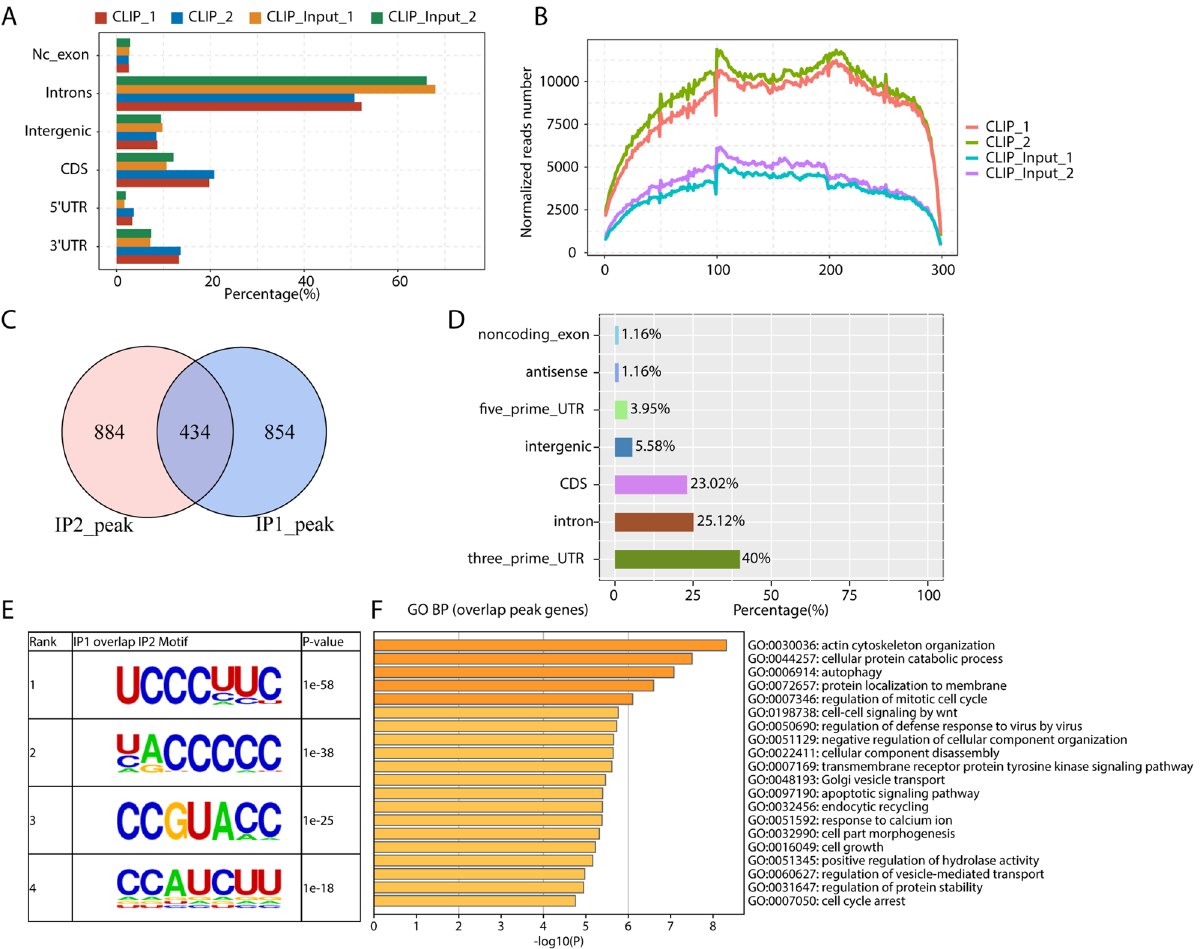
Figure 4. CLIP-seq analysis revealed the RNA binding features of PCBP1 in T lymphoma cell line. ( A ) Bar plot showed the reads distribution across reference genome. ( B) Peak reads density in 5 ′ UTR, CDS and 3 ′ UTR. These three regions of each gene were separated into 100 bins, the UPF1 peak reads in each bin was calculated. The reads density of UPF1 peaks in all genes were plotted. ( C ) Venn diagram showed the overlap peaks in two IP samples. ( D ) Bar plot showed the overlap peaks reads distribution across reference genome. ( E ) Motif analysis showed the top 5 overlapped peaks preferred bound motifs of PCBP1 by HOMER software. ( F) Bar